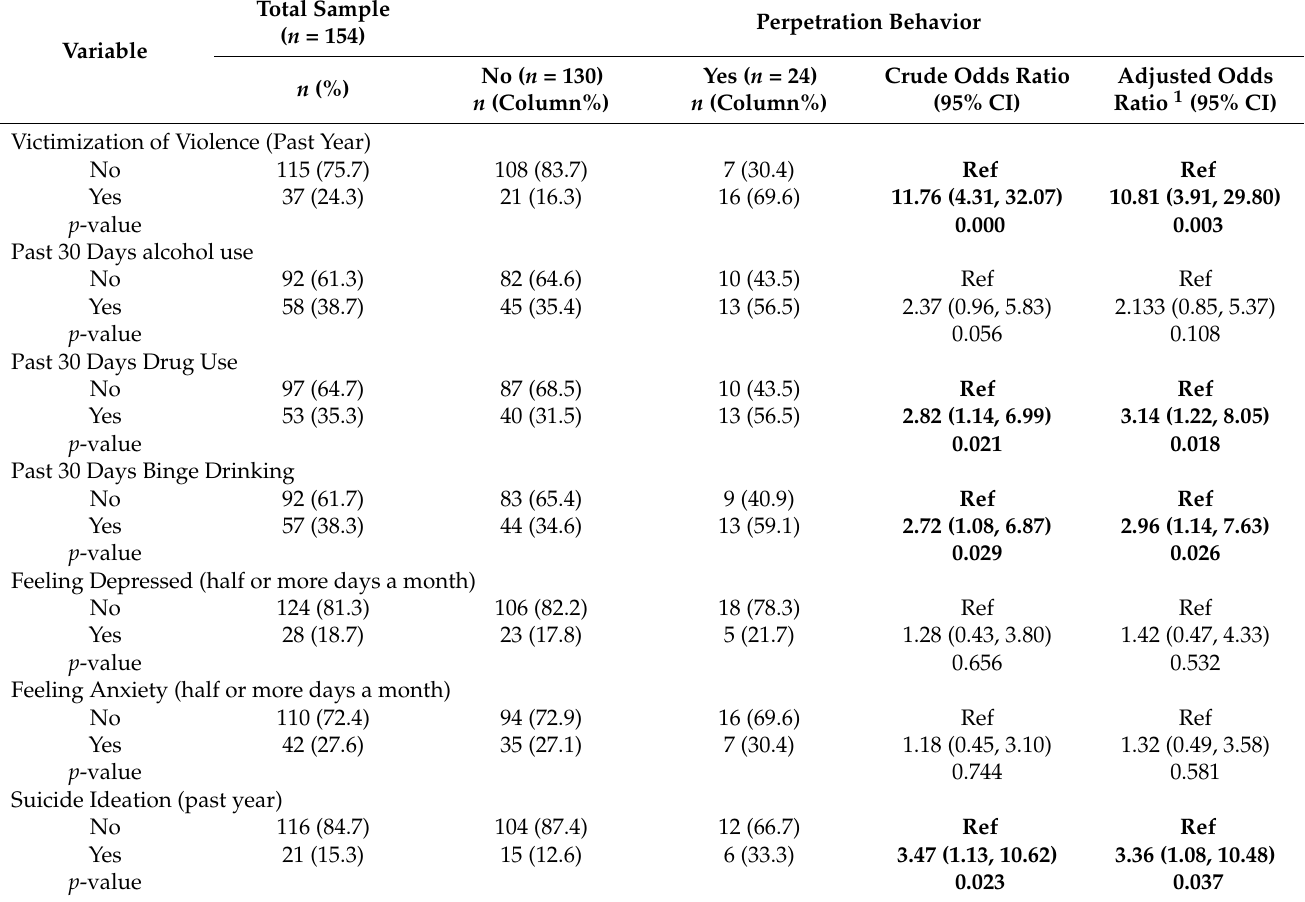
Table 3. IPV Perpetration and Association with Substance Use, Mental Health, and IPV Victimization: Findings from Crude and Adjusted Logistic Regression Models ( n =